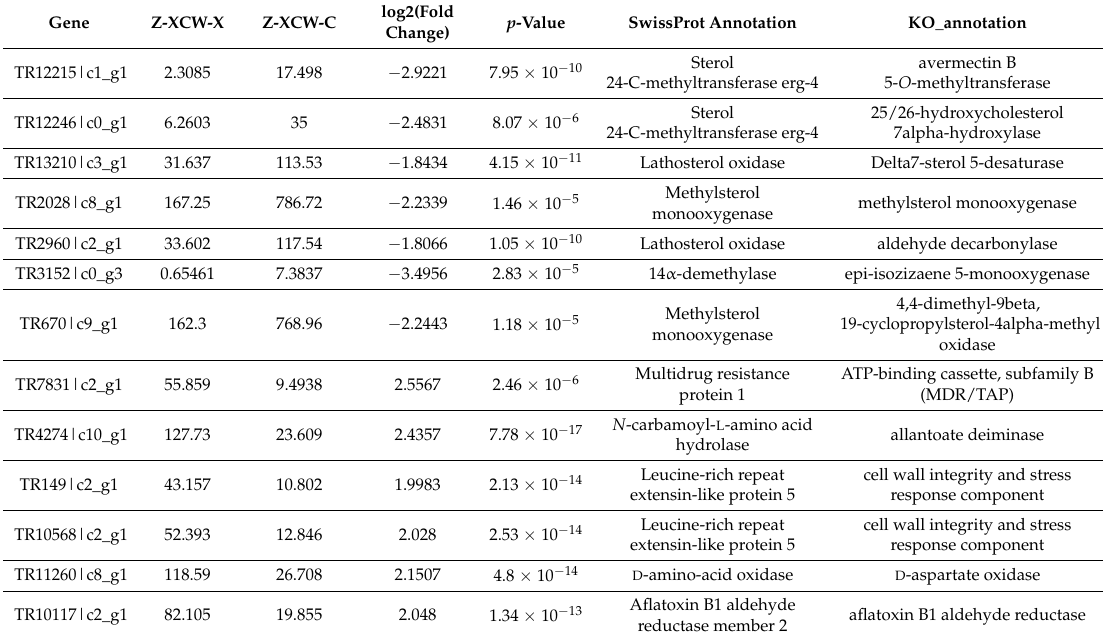
Table 6. Select significantly expressed genes of berberine (Z-XCW-X) vs. control